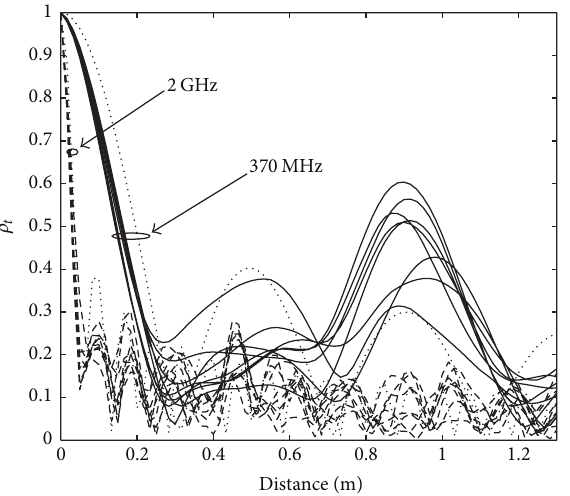
Figure 2: Spatially averaged temporal correlation function for the mid block region at 370MHz (solid lines) and 2 GHz (dashed lines). The model correlation function at 30 km/hr is also shown (dotted lines).